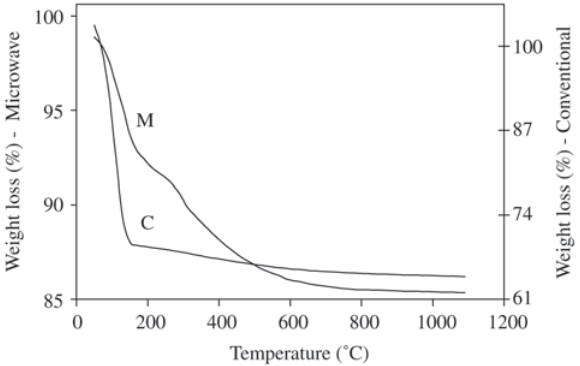
Figure 4. Thermogravimetric analyses of silica gels obtained via conventional (C) heating e via microwave (M)